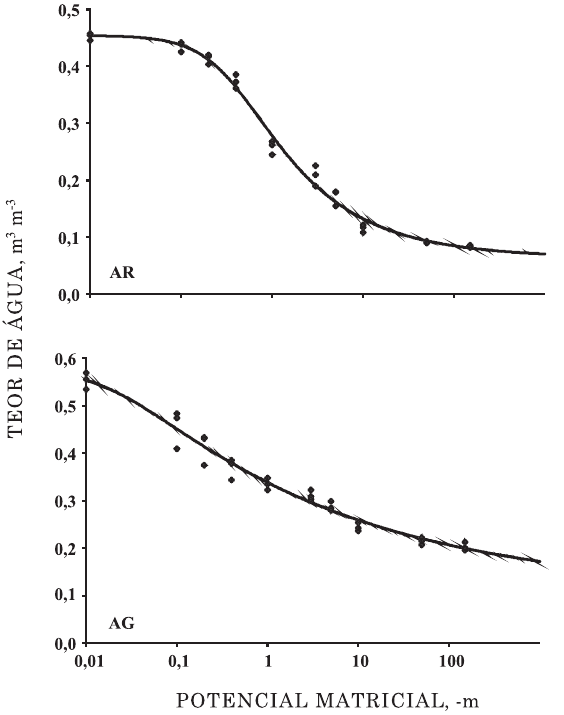
Figura 3. Teor de água em função do potencial matricial nos solos arenoso (AR) e argiloso (AG), sendo os dados obtidos experimentalmente representados por pontos e a equação de van Genuchten (1980) ajustada representada pelas